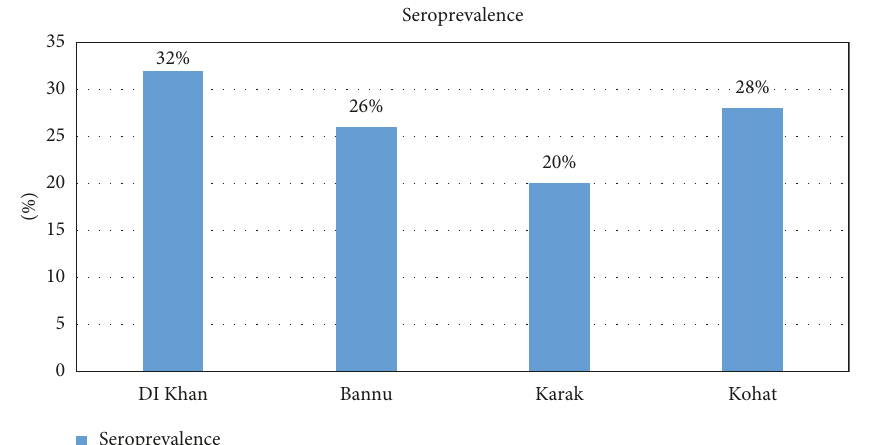
Statistical analysis by χ 2 showed significant association ( P > 0 . 05) among four different districts.